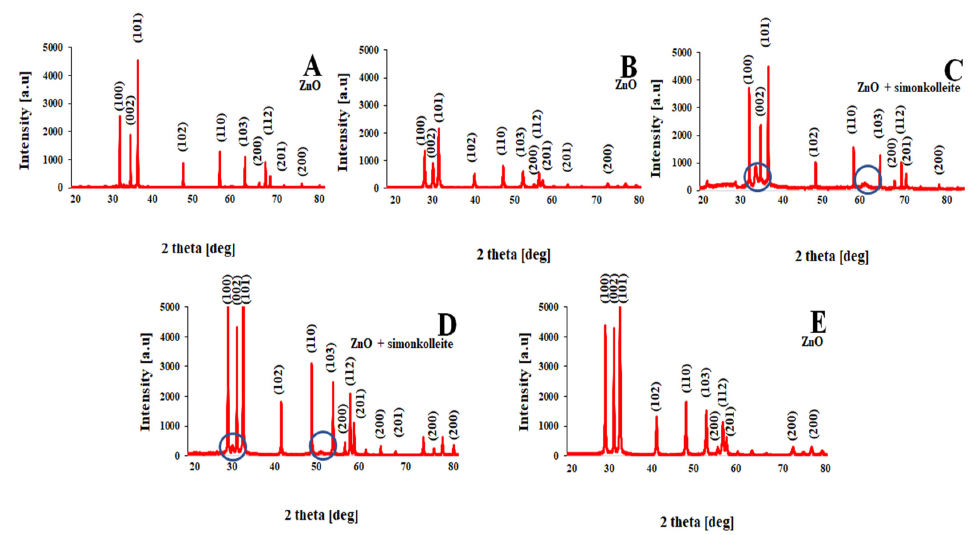
Figure 5. XRD analysis: ( A ) microwave reactor; ( B ) autoclave; ( C ) meander heater; ( D ) Joule type heater; ( E ) impulse reactor.